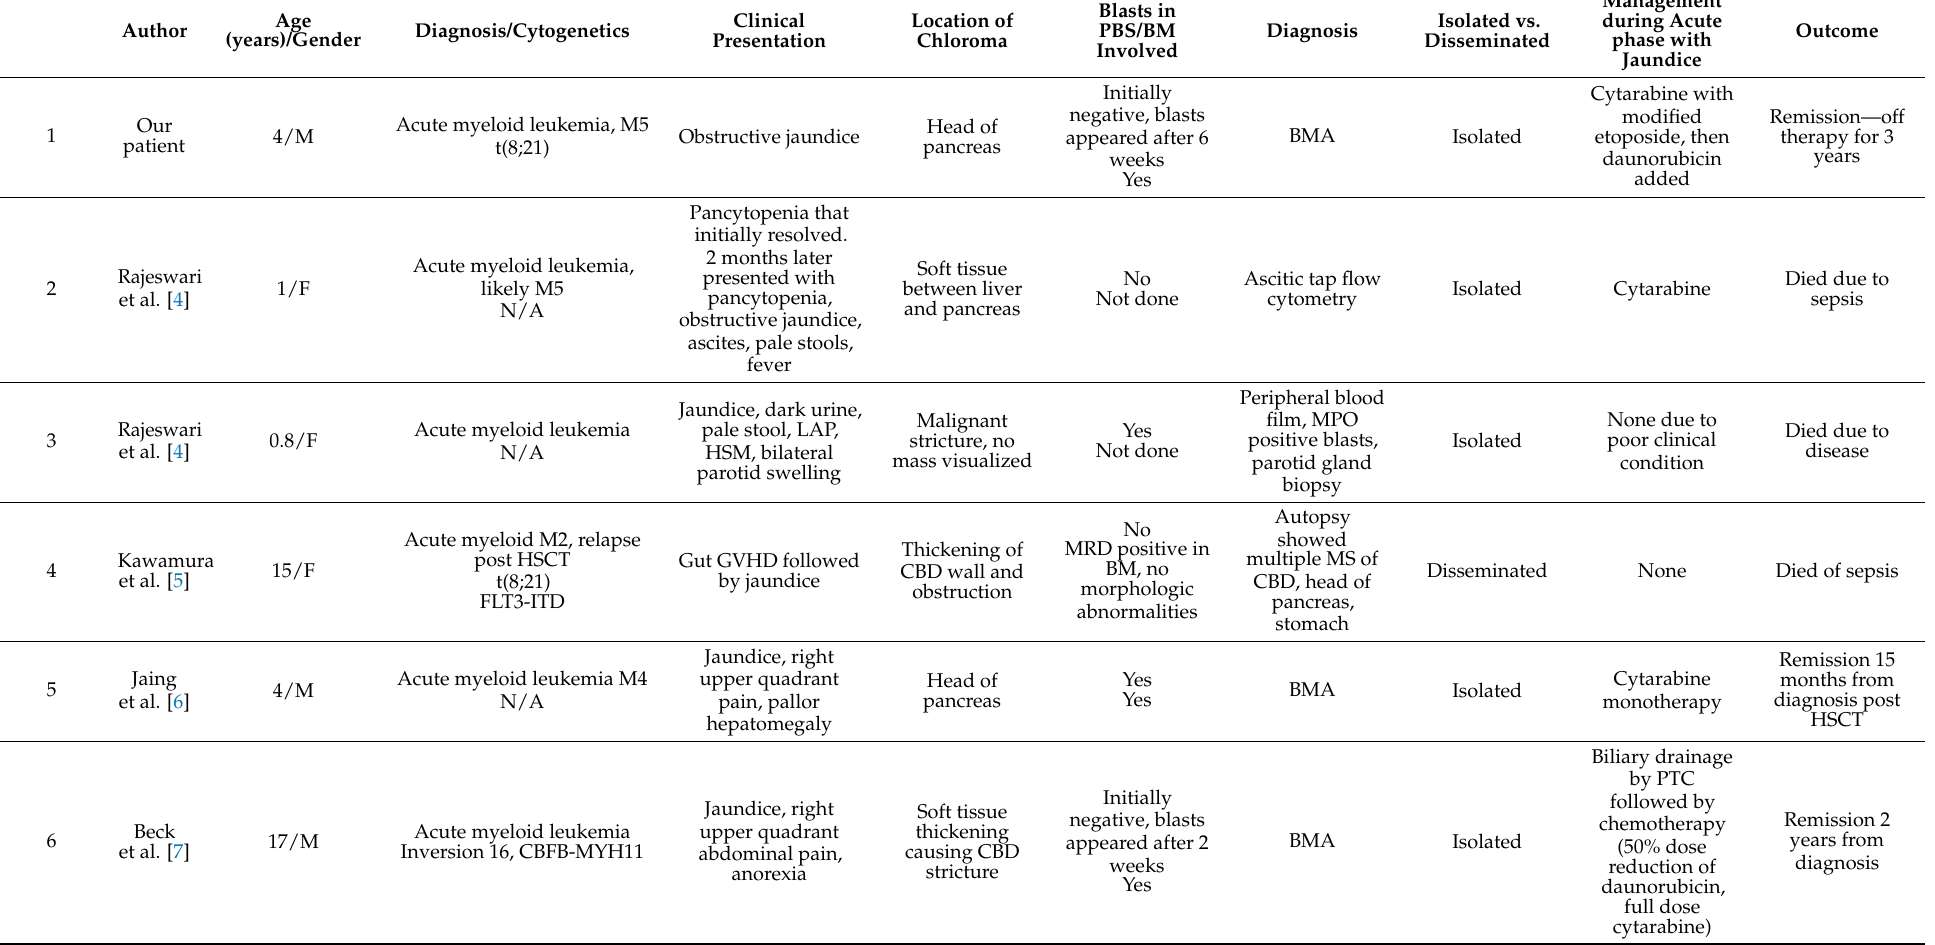
Table 1. Pediatric cases with myeloid sarcoma and obstructive